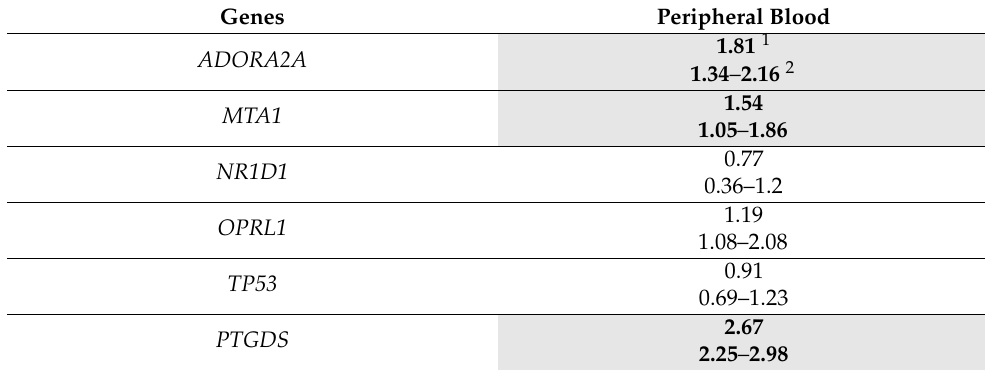
Table 4. Relative mRNA levels of studied genes in the peripheral blood of twins discordant for